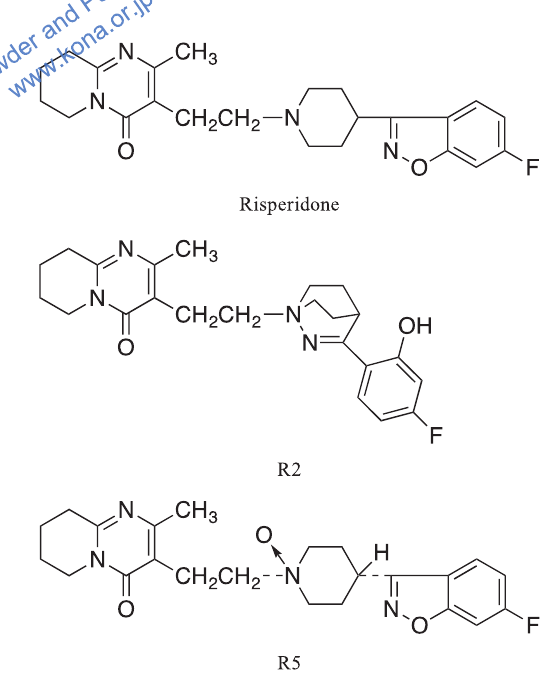
Fig. 1 Structural formulas of risperidone, R2, and